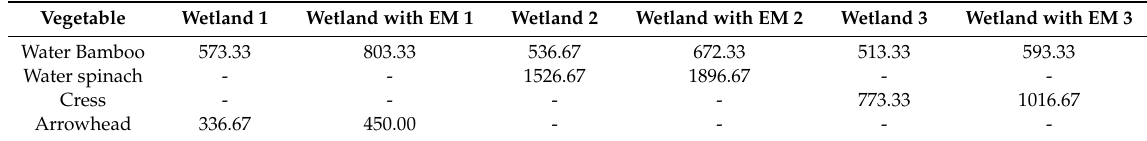
Table 7. Yield of aquatic vegetables in wetlands (kg ha − 1 ).